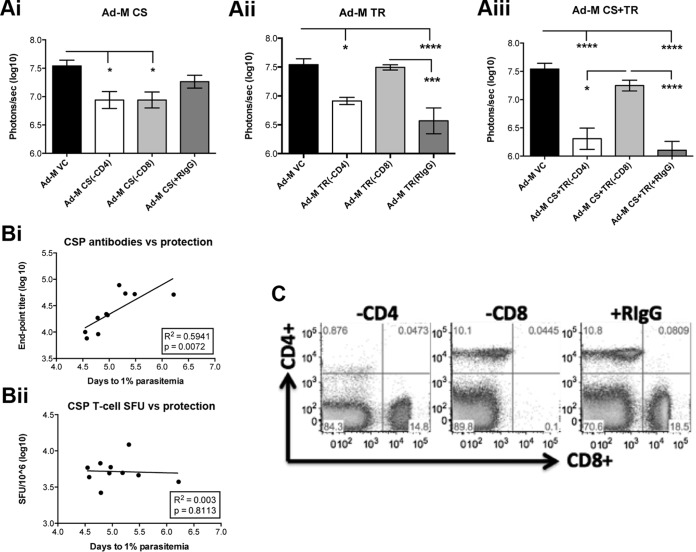
Depletion of CD4+ or CD8+ T cells in mice vaccinated with Ad-M PbCSP or Ad-M PbTR vaccines. (A) C57BL/6 mice (n = 20 per group) were vaccinated with Ad-M CSP (i), Ad-M TR (ii), or a combination of both (iii). A vector control group (Ad-M VC) (n = 10) was included. Two weeks after the boost, a selection of animals from each group (n = 6 per group) were depleted of CD4+ or CD8+ T cells, using three 200-μg intraperitoneal injections of rat GK1.5 or 2.43 MAb, respectively, on days −2, −1, and 0 relative to challenge with 5,000 P. berghei GFP/Luc spz. Control rat IgG1 (+RIgG) antibodies were used as an injection control (n = 8 per group). At 44 h after challenge, the BLS emitted from infected animals was quantified. Means with the standard errors of the mean (SEM) are shown. *, P < 0.05; ***, P < 0.001; ****, P < 0.0001 (as determined by one-way ANOVA with Bonferroni's multiple-comparison posttest). (B) A strong correlation between time to reach 1% parasitemia (Tto1) and anti-PbCSP Ab titers (i), but not ex vivo IFN-γ ELISPOT responses (ii), suggests that protection is mainly mediated by Abs in Ad-M CSP vaccination. (C) Representative FlowJo plots demonstrate the depletion of CD4+ or CD8+ T cells compared to vaccinated animals that received control rat IgG1.